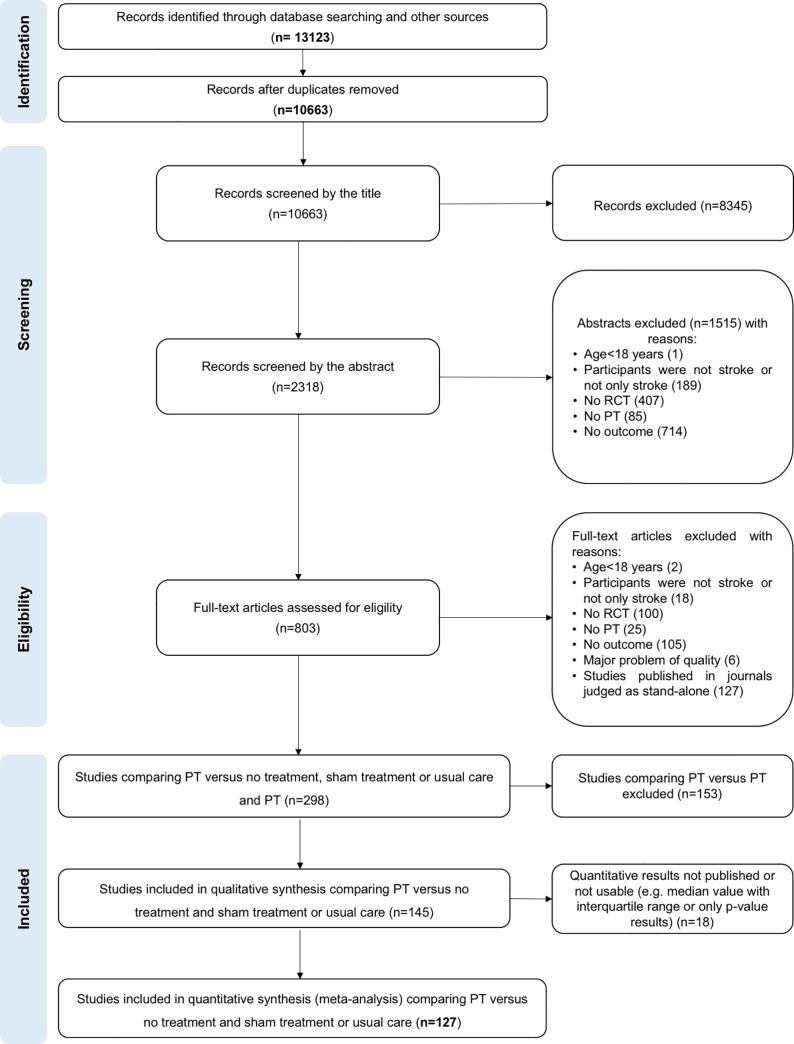
Study flow diagram.